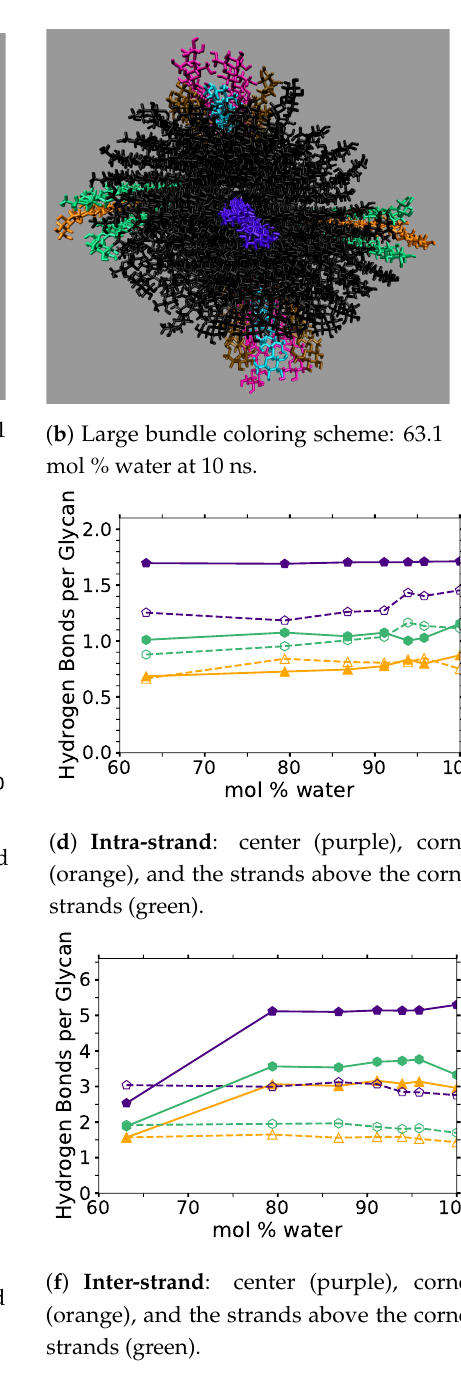
Figure 6. Average inter-stand and intra-strand hydrogen bonding comparison between the small and large cellulose bundles at various water concentrations: ( a ) small bundle coloring scheme; ( b ) large bundle coloring scheme; ( c ) the intra-strand hydrogen bonds for the first and second layers; ( d ) the intra-strand hydrogen bonds for the center, corner, and the strands above the corner strands; ( e ) the inter-strand hydrogen bonds for the first and second layers; ( f ) the inter-strand hydrogen bonds for the center, corner, and the strands above the corner strands. All data points were averaged from 10 to 20ns. The solid lines and filled markers represent the large cellulose bundle, and the dashed lines and unfilled markers represent the small cellulose bundle. The colored strands are matched and compared between the plots for the small and large bundles and the images in this figure to identify similar hydrogen bonding behavior based on their locations (see Figure 6a,b for the color-coded images). The black cellulose strands are not compared. The small and large cellulose bundle intra-strand hydrogen bonding is based on 11 glycans and 23 glycans, respectively, as the last glycan has no potential bonding